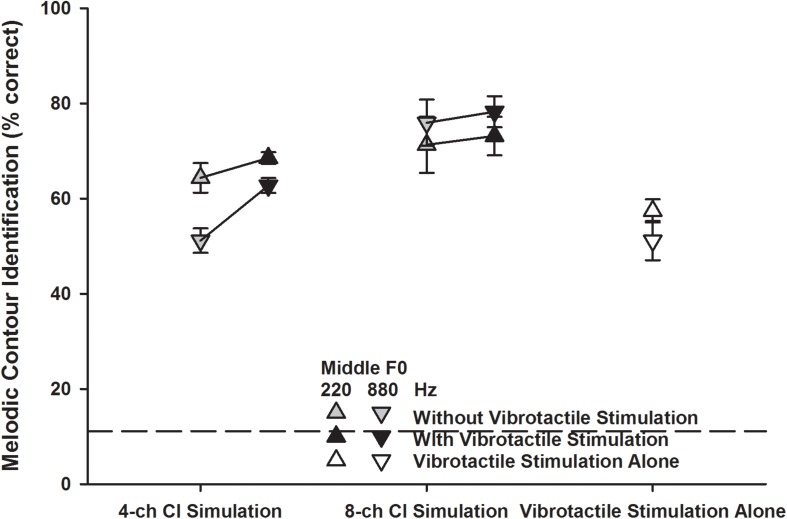
Melodic contour identification scores for the 220 and 880 Hz middle F0s (upward and downward triangles, respectively) with the 4- or 8-channel CI simulation (left and middle line plots, respectively) with or without vibrotactile stimulation (black and gray triangles, respectively) or with vibrotactile stimulation alone (white triangles). Symbols represent the mean, while error bars represent the standard error across participants. The horizontal dashed line indicates the chance performance of 11% correct.